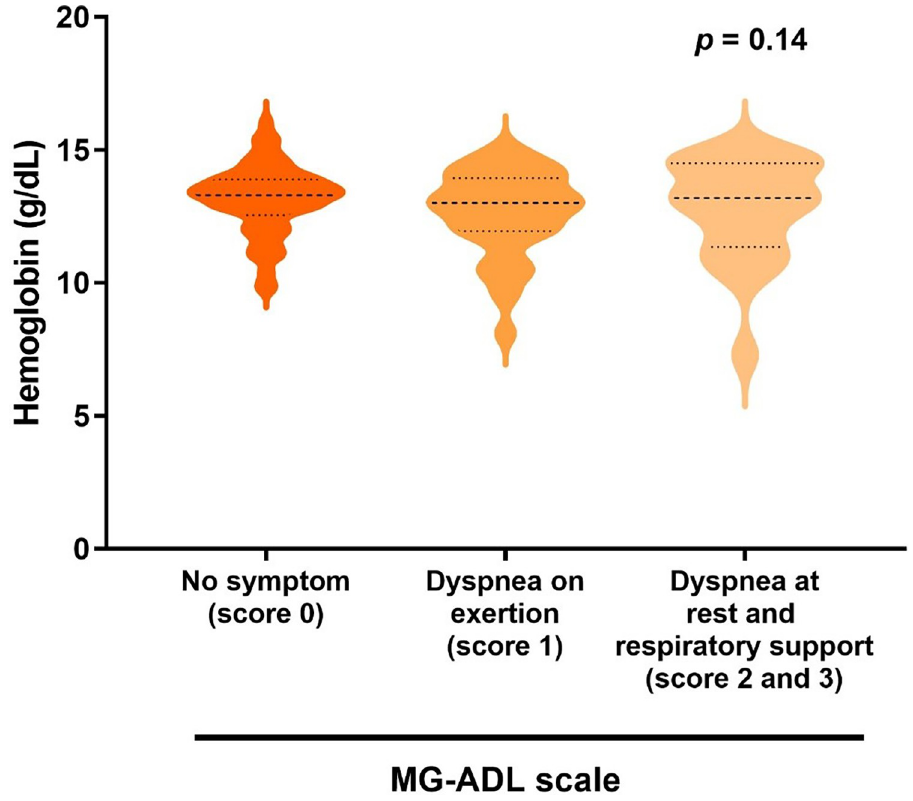
Fig 4. Correlation between breathing status stratified by myasthenia gravis activities of daily living (MG-ADL) and hemoglobin levels in 215 female MG patients with anemia. Dotted lines indicate quartile levels.